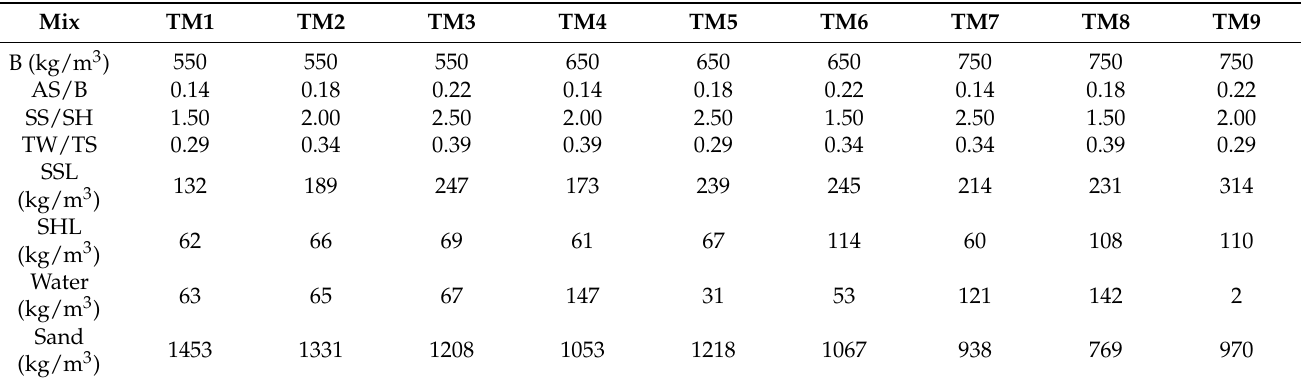
Table 2. Mix proportions for each Taguchi